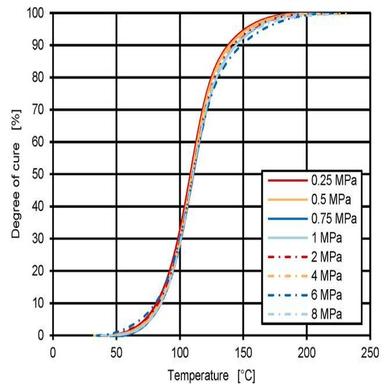
Pressure dependence of curing reaction measured via dynamic DSC scans.